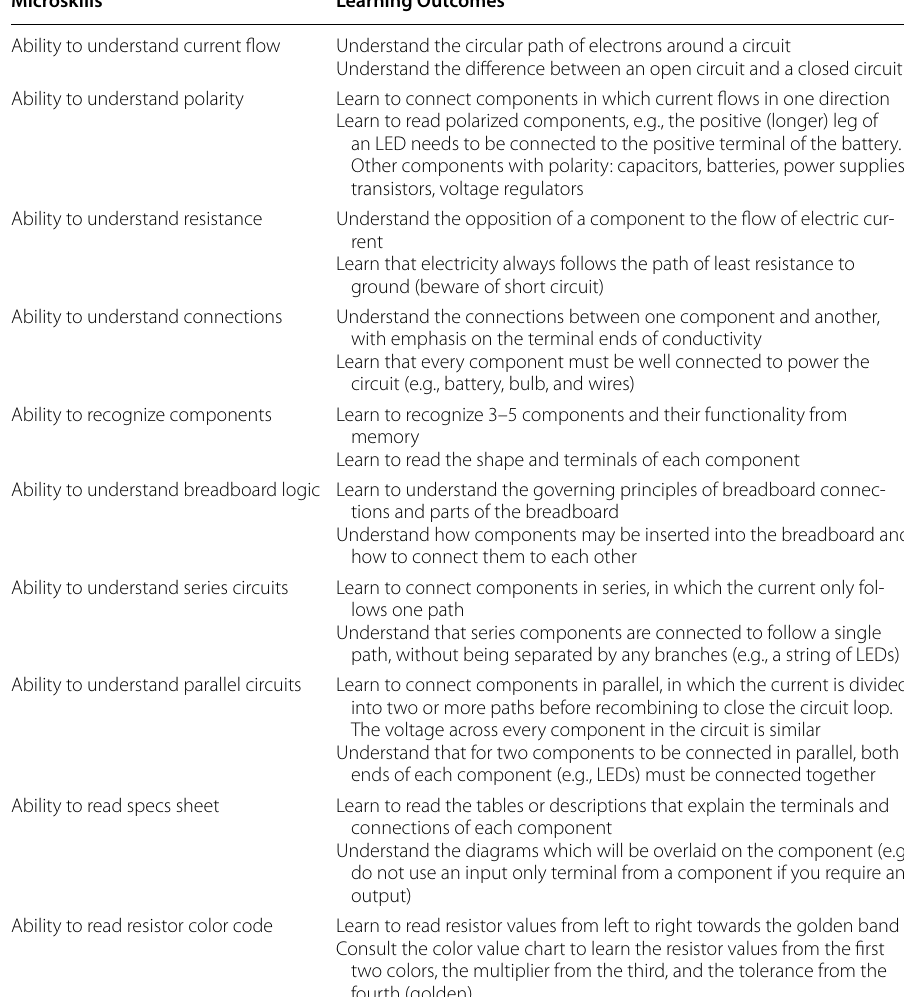
Table 2 Microskills and learning outcomes Microskills Learning